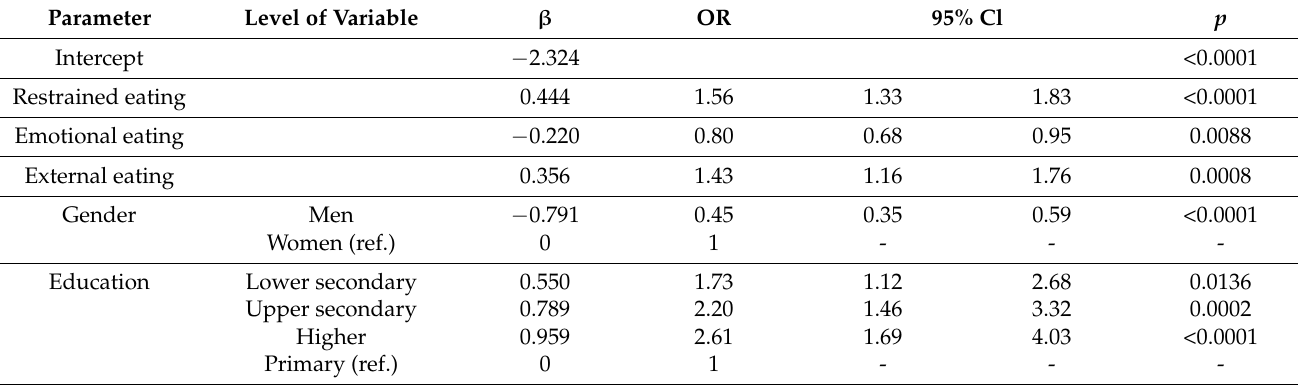
Table 11. Adequate intake of fruit and vegetables’ odds ratios (OR; 95% CI) in the study sample. Parameter Level of Variable